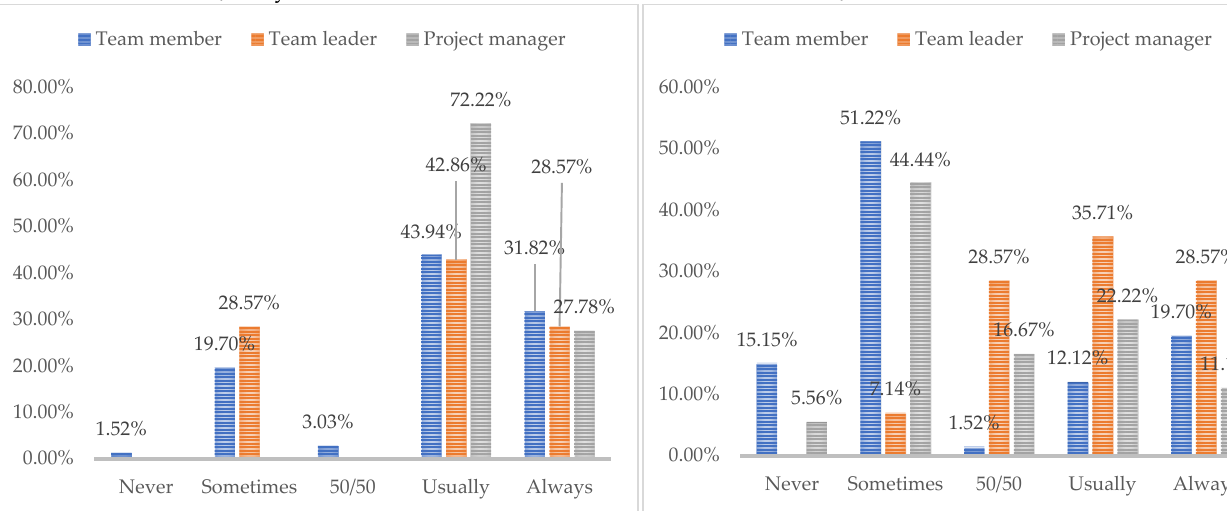
Figure 2. Assessment of risk factors during project planning (n = 98).